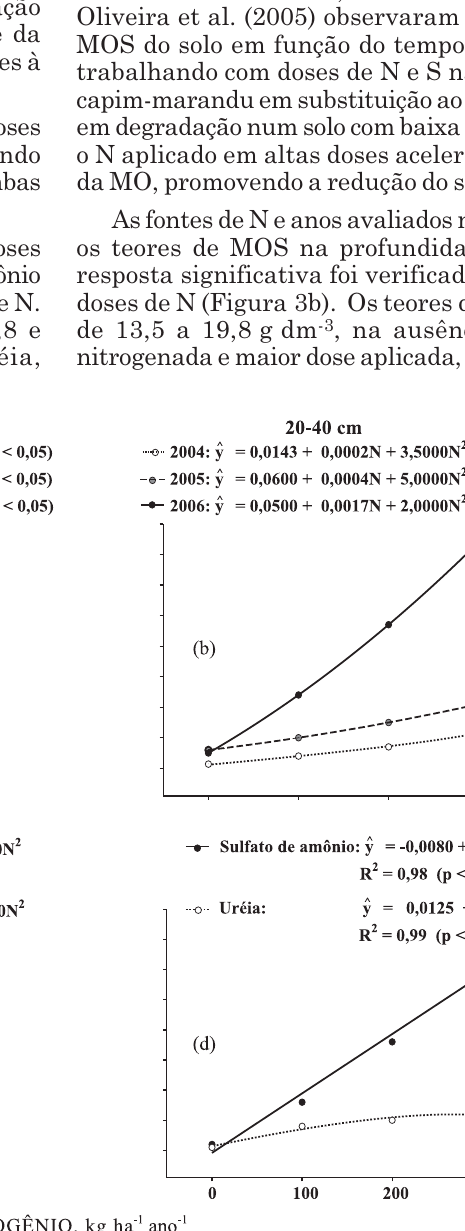
Figura 2. Efeito de doses e de fontes de nitrogênio sobre o teor de alumínio do solo avaliado em